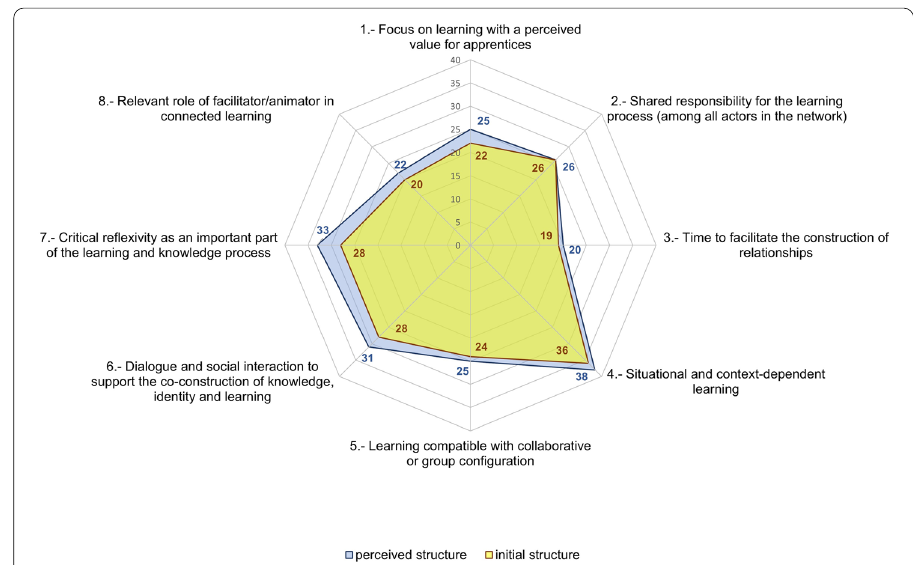
Fig. 3 NLP differences between perception structure and initial structure for NLP. The scale represents the maximum value observed between initial and perceived structures. Source: Authors’ elaboration